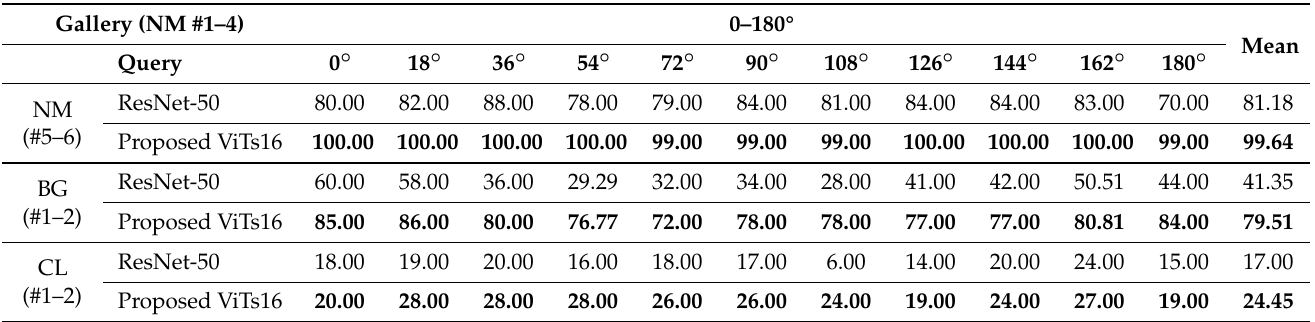
Table 5. Comparison of Resnet-50 and small ViT model accuracy on CASIA-B dataset using LT setting. The best results for each angle and overall are in bold.